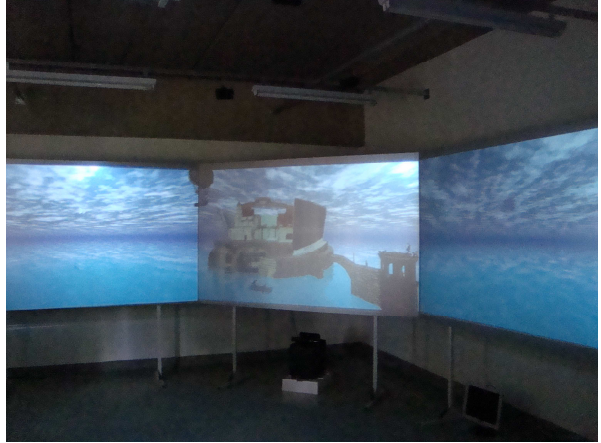
Fig. 9 - Torre de Papel 3D running in the Mini-CAVE